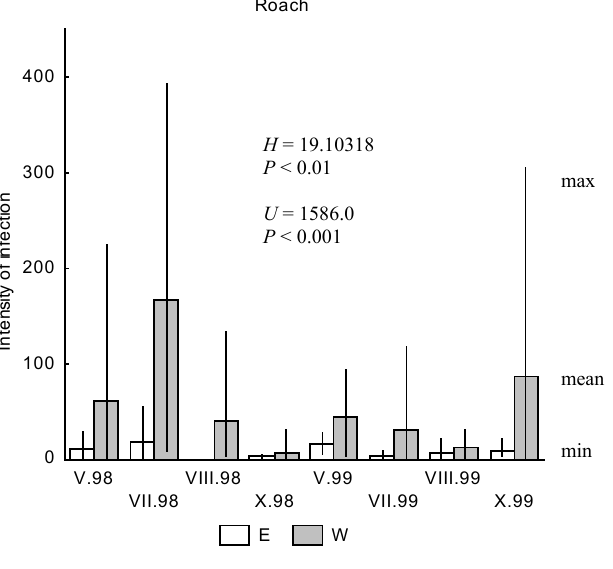
Fig. 3. Intensity of infection of roach with P. cuticola in samples from eastern- (E) and western (W) part of OÊwin Lake; H , Kruskal–Wallis statistic for seasonal differences; U , Mann–Whitney statistic for location